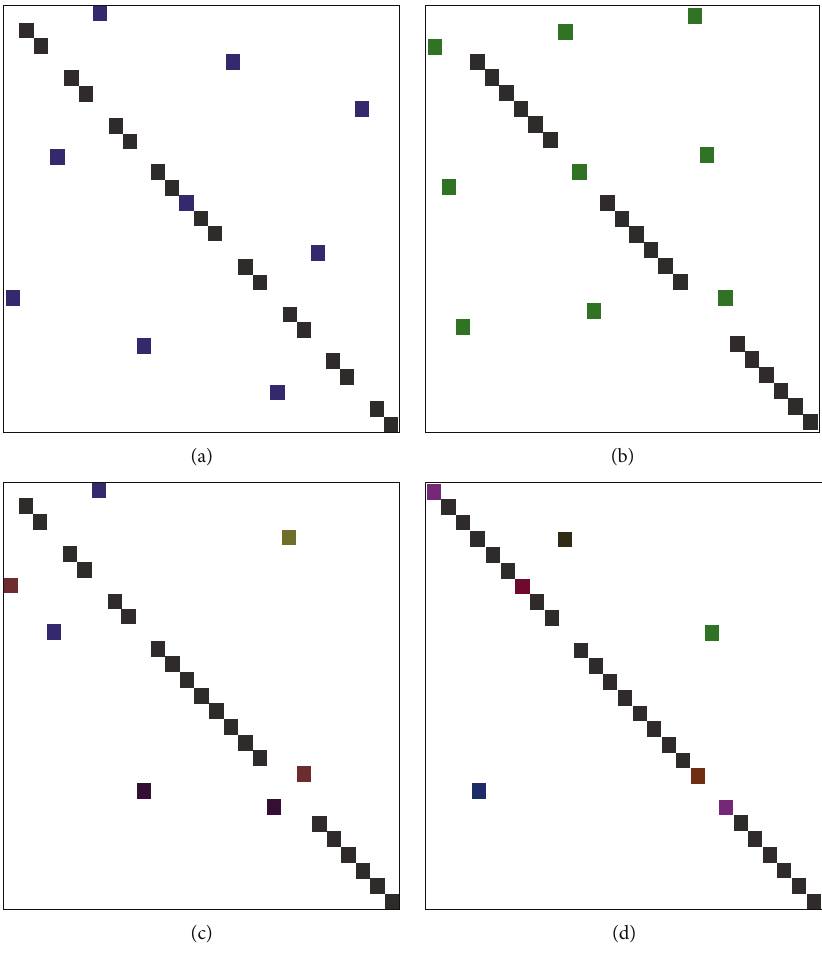
ℝ K ; (d) K 2 Z ,0 ; (b) Y ,0 ; (c)